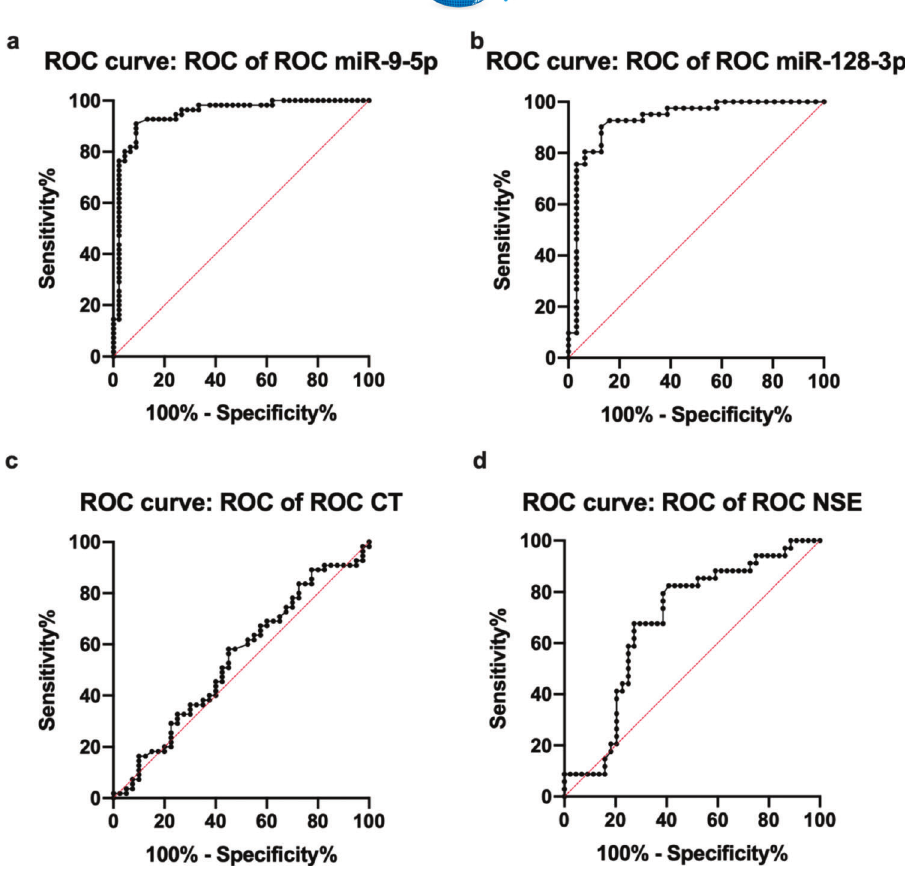
Figure 3 - Predictive value of serum miR-9-5p and miR-128-3p levels in patients with acute ischemic stroke, as evaluated by receiver operator characteristic (ROC) curve analysis. a) ROC curve of serum miR-9-5p levels. b) ROC curve of serum miR-128-3p levels. c) ROC curve of computed tomography findings. d) ROC curve of neuron-specific enolase (NSE) levels in the serum. * p o 0.05. Table 4 - Correlation of the serum miR-9-5p and miR-128-3p levels with the modified Rankin scale scores.